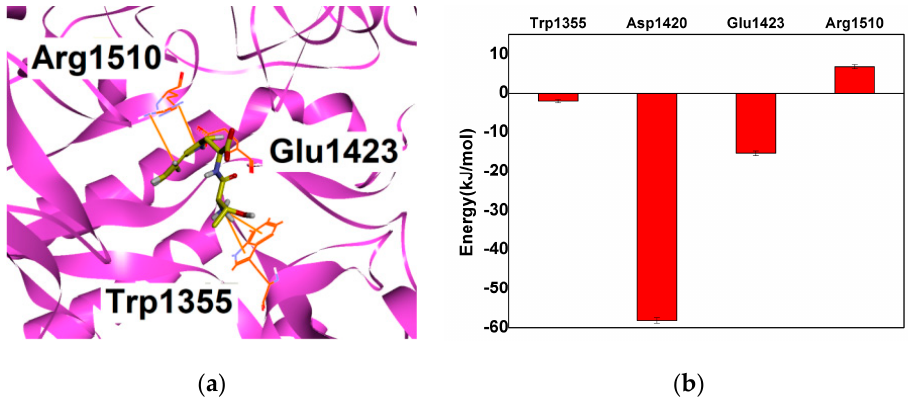
Figure 5. ( a ) The cation ‐π interaction of cluster 1 from MGAM ‐ TW and ( b ) the energy contributions of the vital residues of cluster 1 from MGAM ‐ TW. The errors marked on the graph represent the absolute errors of the data.